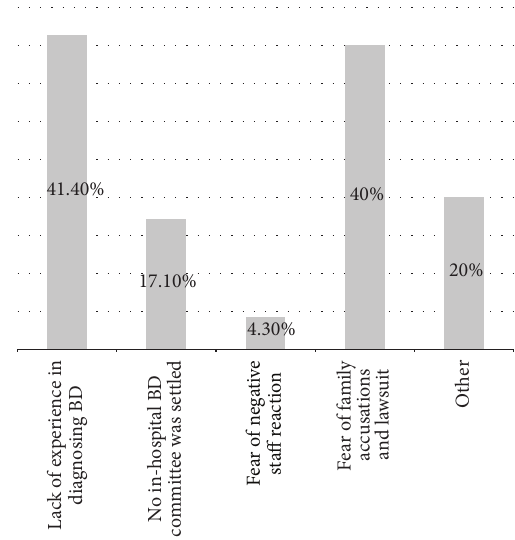
Figure 2: What are the reasons for not proceeding to formal diag- nosis when clinical signs of BD are present? ( 𝑛 = 70 respondents).